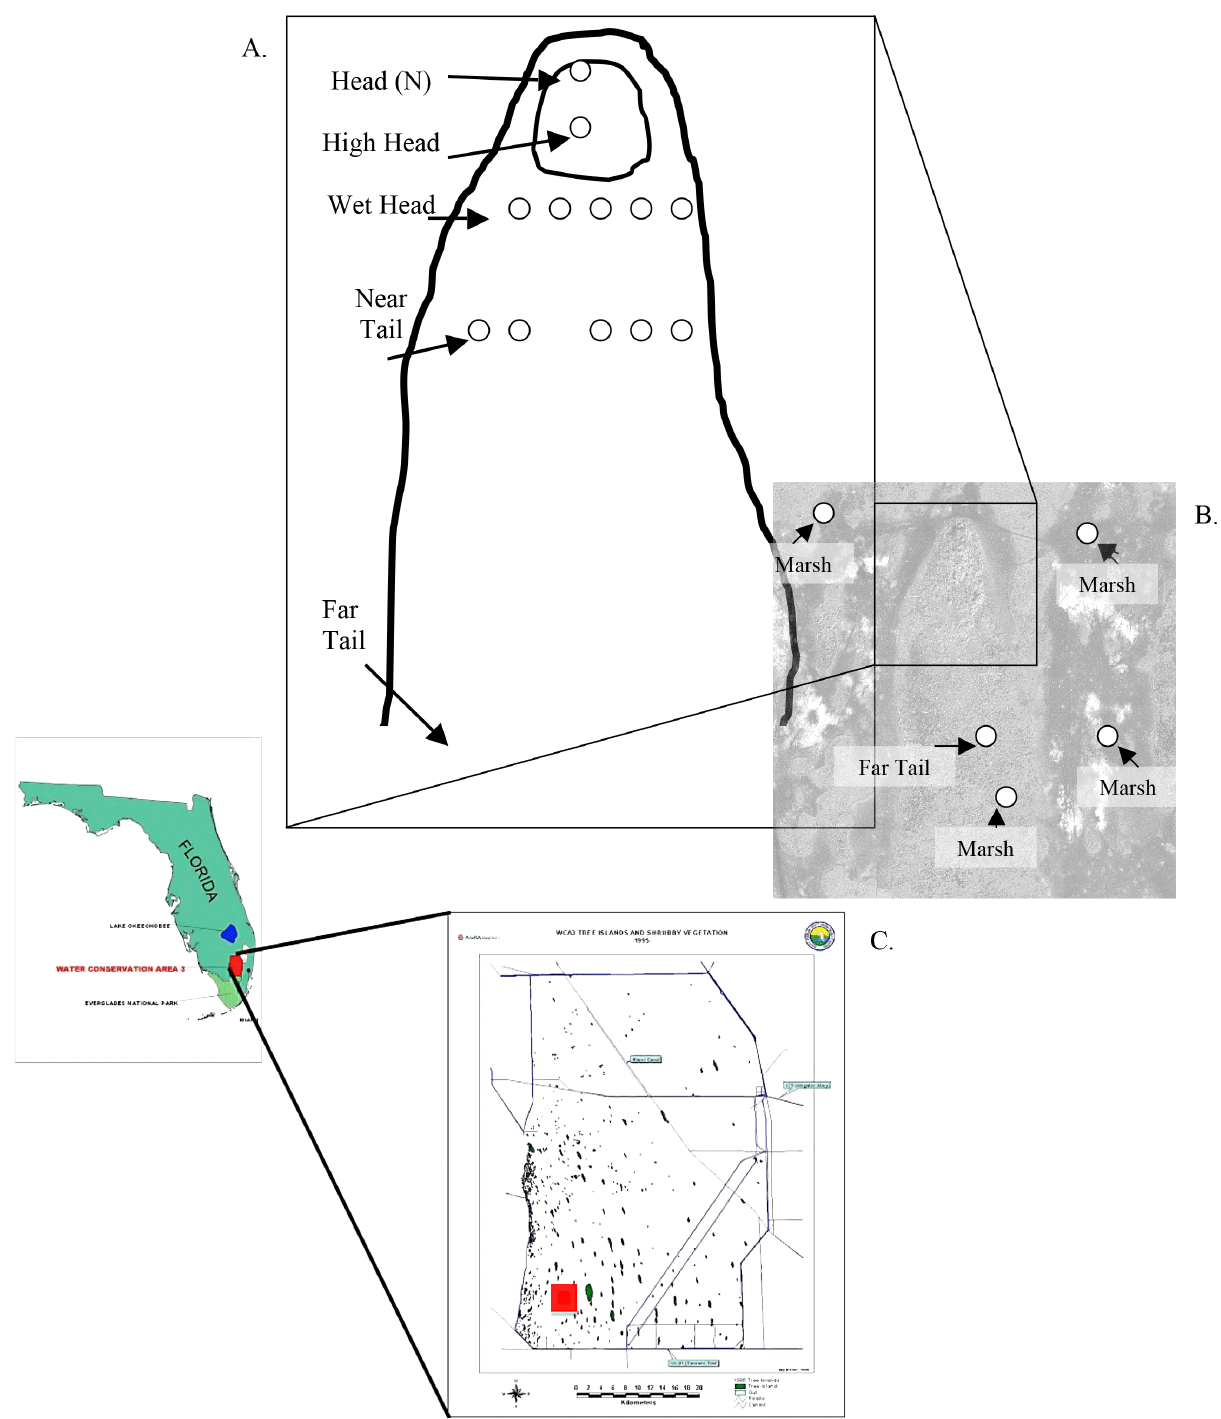
Fig. 1. Map of tree island piezometer (A) and well locations (B) . Piezometers were installed to a depth of 0.3 and 0.6m. Wells were installed to a depth of 2 and 8m. At the Far Tail location there were both piezometers and wells as described. Also illustrated is the tree island 3AS3 study site (red box) in the WCA 3A (C) in